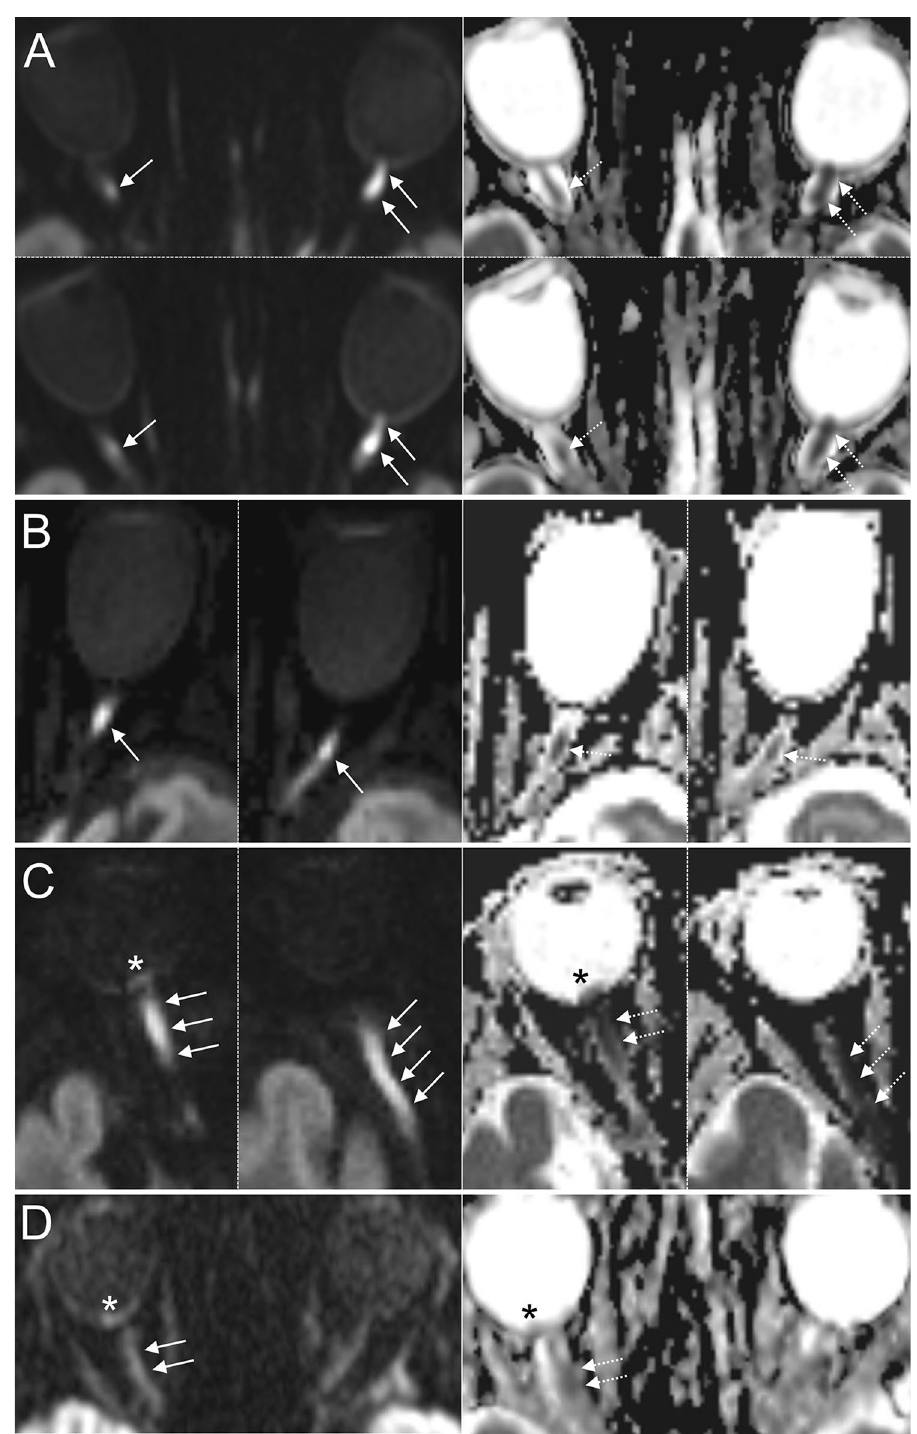
Figure 3. Examples of DWI-MRI in 4 patients with GCA and arteritic ION involving the intraorbital part of the ON (left row: DWI b = 1000 s/mm2, right row: corresponding ADC images). ( A ) Two consecutive DWI-MRI slices of a GCA patient showing bilateral restricted diffusion of the ON (white arrows; right: intraorbital, left: bordering ONH and intraorbital portion) and corresponding ADC reduction (dotted arrows) suggestive of right posterior ION and left anterior ION. ( B ) Restricted diffusion of the intraorbital part of the ON on two consecutive DWI-MRI slices (white arrows) and corresponding ADC reduction (dotted arrows) in a patient with left ION. ( C ) Acute ocular ischemic syndrome in GCA: Two consecutive DWI-MRI slices showing extensive restricted diffusion of the ON involving the ONH and the intraorbital portion (white arrows) with corresponding qualitative ADC reduction (dotted arrows). Note the presence of retinal diffusion restriction indicating concomitant retinal ischemia (asterisks). The findings are indicative of combined arteritic anterior/posterior ION and retinal artery occlusion. ( D ) Example of 1.5 T DWI showing right-sided restricted diffusion of the intraorbital optic nerve (white arrows) and retina (white asterisk) with subtle qualitative ADC reduction. Abbreviations: ION,